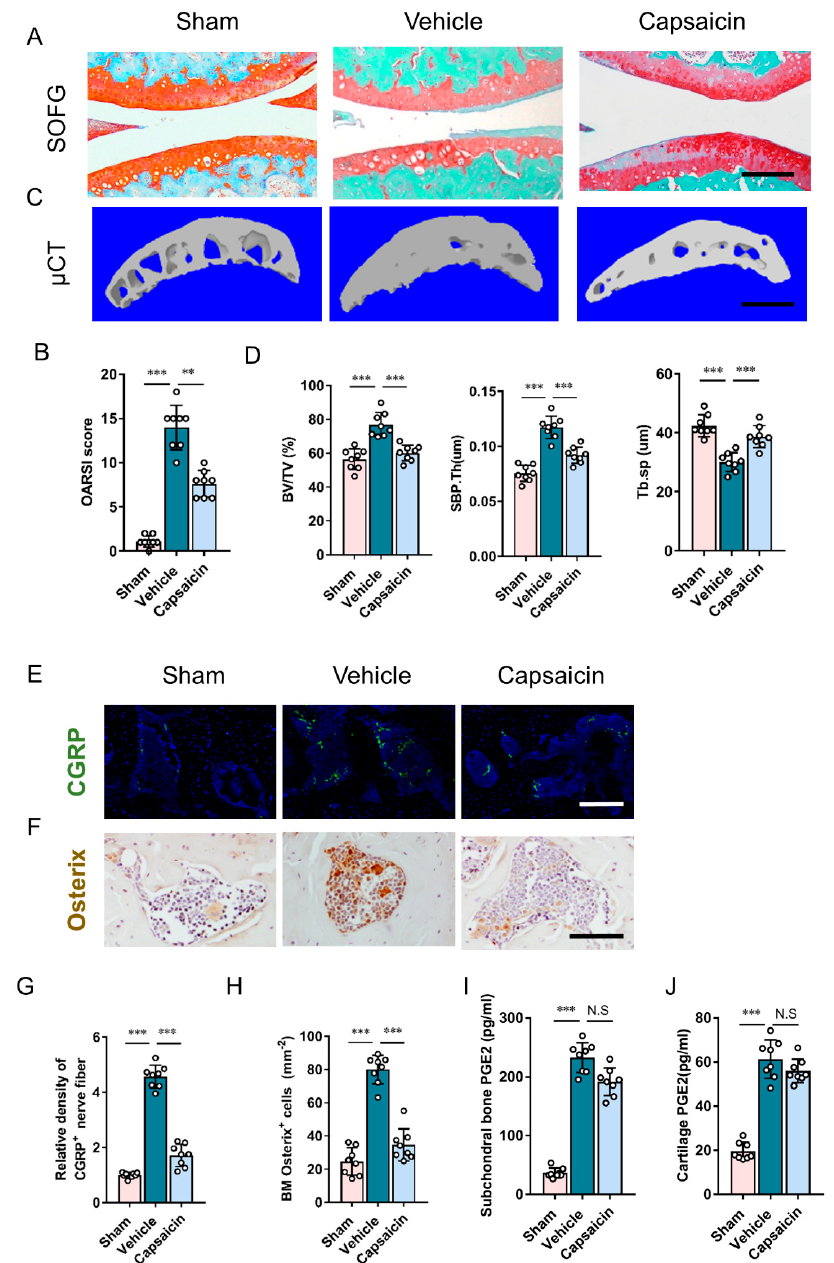
Figure 5. Sensory denervation stabilizes subchondral bone architecture and reduces cartilage degeneration following DMM surgery. ( A ) SOFG staining of tibia subchondral bone (sagittal section). Scale bar: 250 µ m. ( B ) µ CT images of subchondral bone (sagittal view). Scale bar: 500 µ m. ( C ) OARSI scores at eight weeks following surgery. n = 8 mice per group. ( D ) Quantitative analysis of subchondral bone fraction (BV/TV), Tb.Sp and SBP.Th eight weeks following surgery. n = 8 mice per group. ( E , G ) Representative images ( E ) and quantitative analysis ( G ) of immunofluorescent staining of CGRP (green) + sensory nerves in subchondral bone at four weeks following surgery. Scale bar: 50 µ m. ( F , H ) Representative images ( F ) and quantitative analysis ( H ) of immunochemical staining of osterix+ (brown) osteoprogenitors in subchondral bone four weeks following surgery. Scale bar: 50 µ m. ELISA analysis of PGE2 concentration in tibial subchondral bone ( I ) and articular cartilage ( J ). n = 5 mice per group. ** p < 0.01, *** p < 0.001, and N.S. means